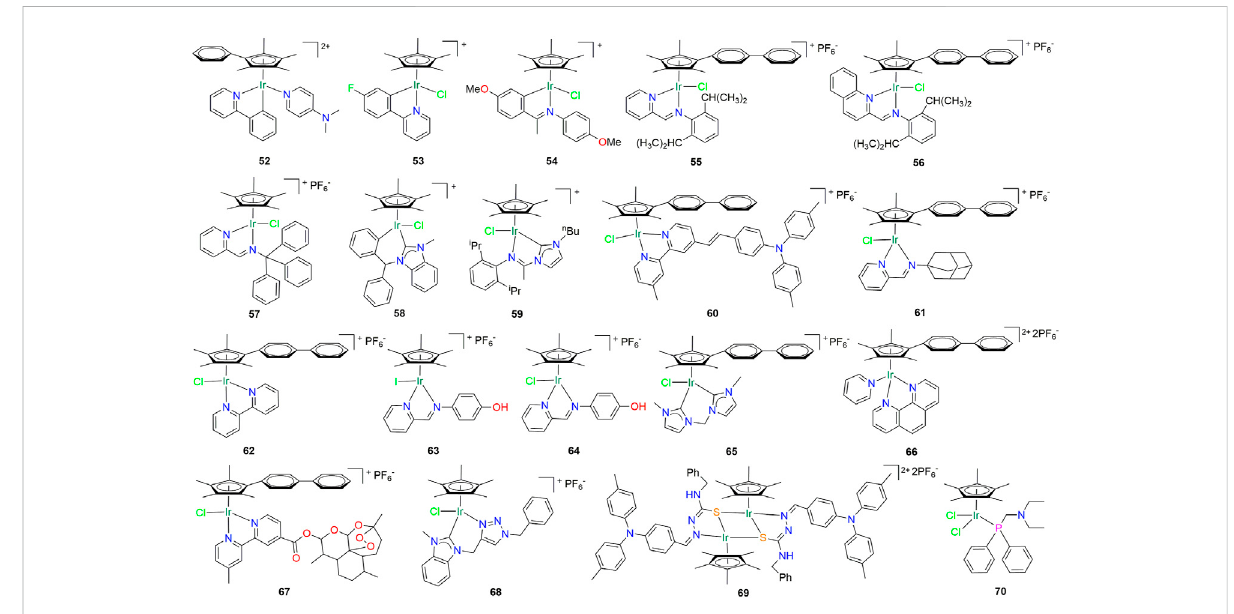
FIGURE 5 Structure of anti-lung cancer half-sandwich iridium (III) complexes ( 52 – 70